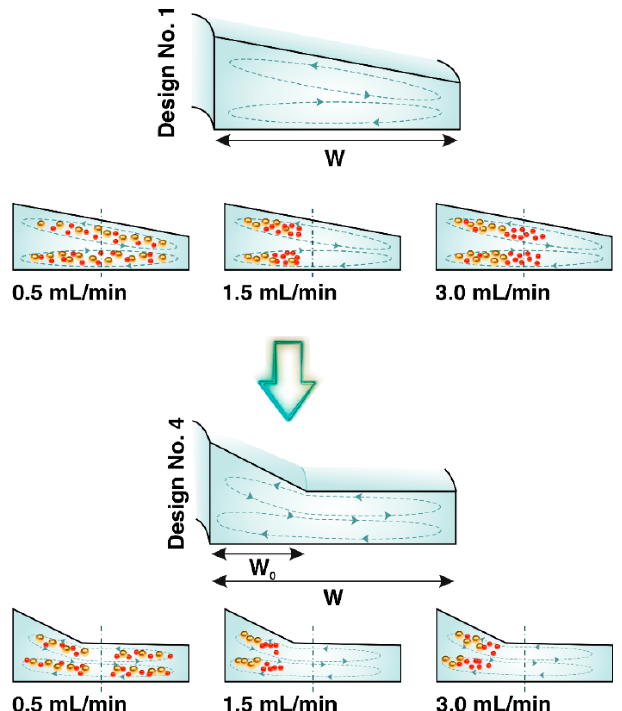
Figure 5. Schematic (not to scale) of trapezoidal (Design No.1) and complex cross-section (Design No.4) and lateral position for a differential displacement of particles at different flow rates. Schematic shows particles through Design No. 4 focused closer to the inner wall, progressively displaced away from the inner wall without de-focusing by increasing fluid velocity. This suggests that precise control of the lateral position can be achieved through a channel with a complex cross-section.